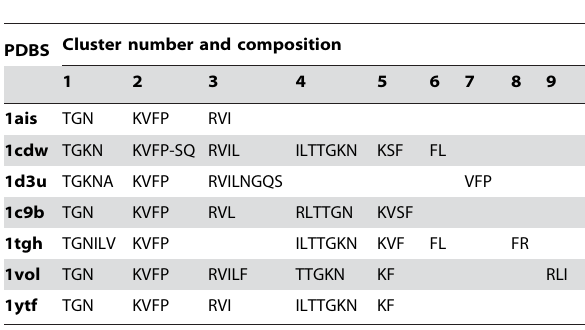
Table 2. Commonly occurring P-S clusters (at MEC =5%) in b - sheet proteins.